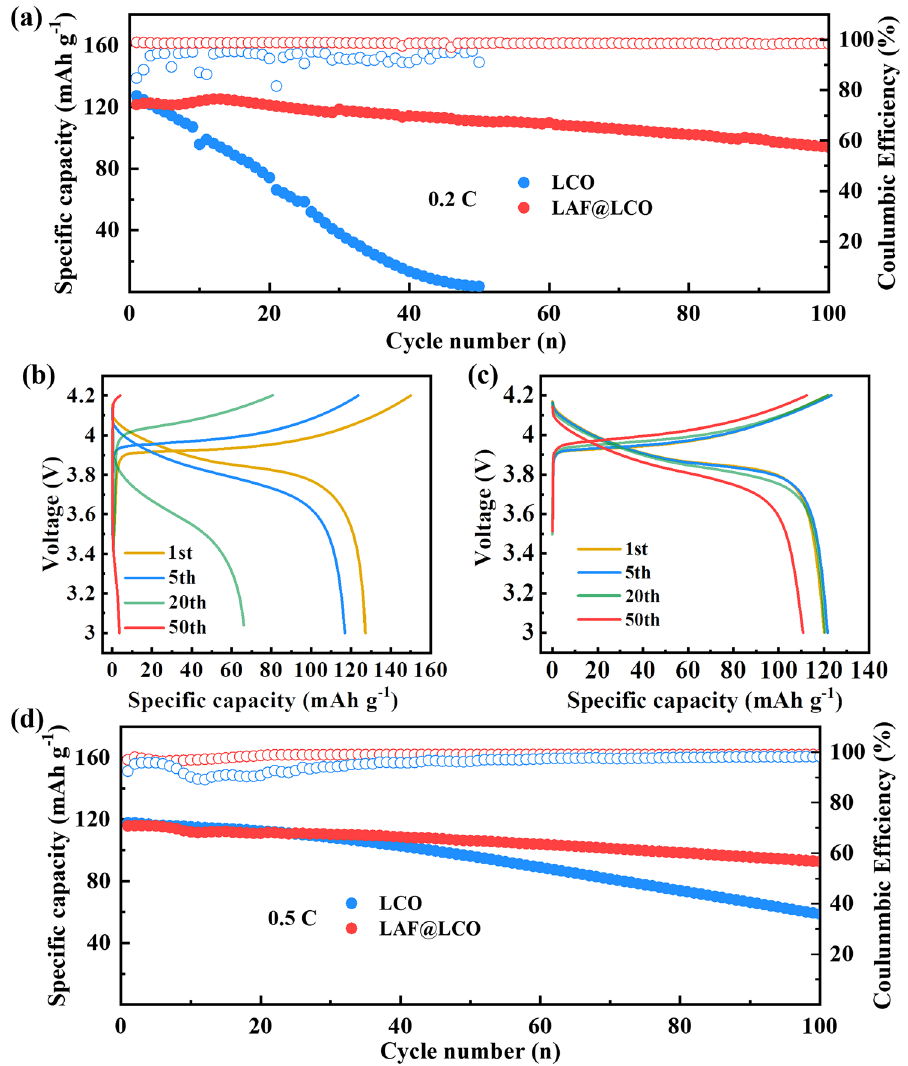
Fig. 2 a The discharge capacity and Coulombic efficiency at 0.2C for 100 cycles. Charge/discharge profiles of b LCO/PEO-LiTFSI/Li cell, c LAF@LCO/PEO-LiTFSI/Li cell. d The discharge capacity and Coulombic efficiency at 0.5C for 100 cycles. All cells were tested at 60 °C and pre-cycled for five cycles at